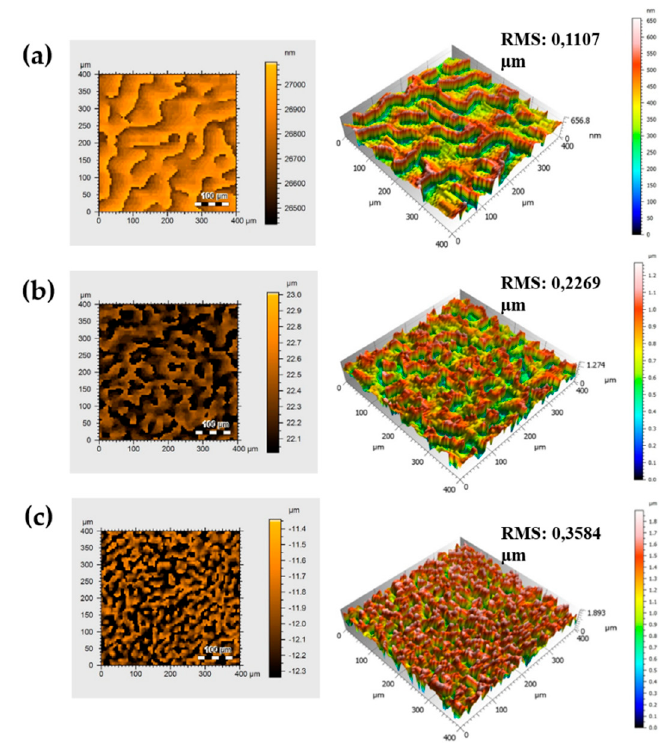
Figure 2. Profilometry analysis of the PDMS samples; top view results on the left-side and 3D maps on the right-side together with root mean square (RMS) values for: ( a ) LDSU; ( b ) MDSU and ( c ) HDSU,